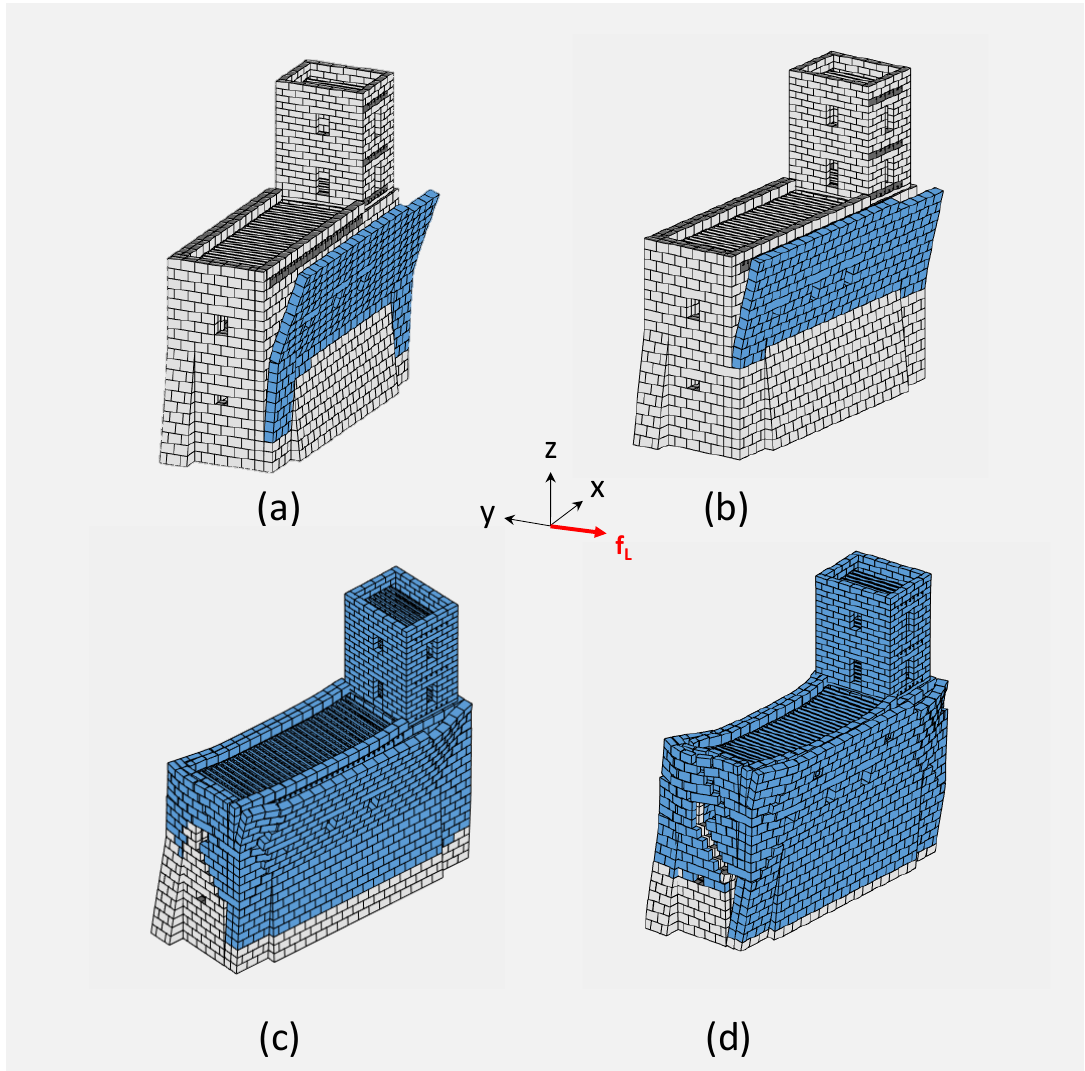
Figure 15. Collapse mechanisms and participating masses (in blue) provided by LiABlock_3D for the load case LC1 (live loads f L along the positive x-axis): ( a ) the castle wing in its present condition; ( b ) retrofitting intervention n.1 (R1); ( c ) retrofitting intervention n.2 (R2); ( d ) retrofitting intervention n.3 (R3). Quoins in red; washer-bearing plates in green.